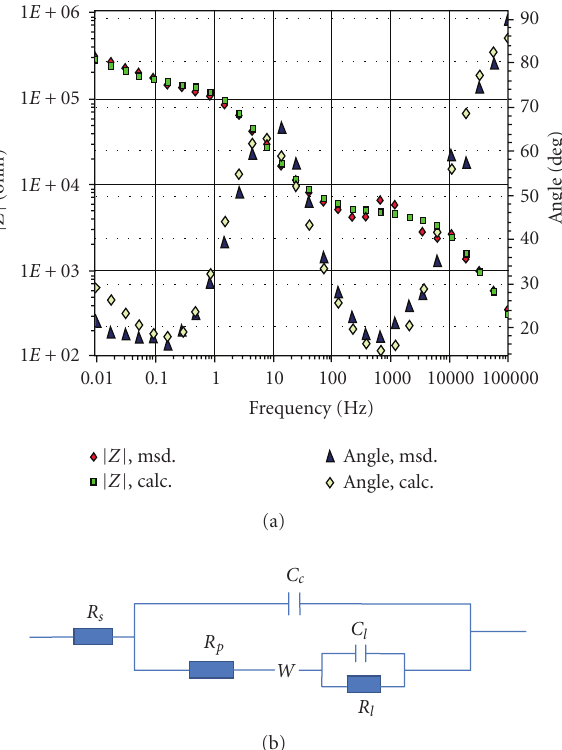
Figure 4: EIS Bode graph, equivalent circuit, and imitation result after 336-hour test.